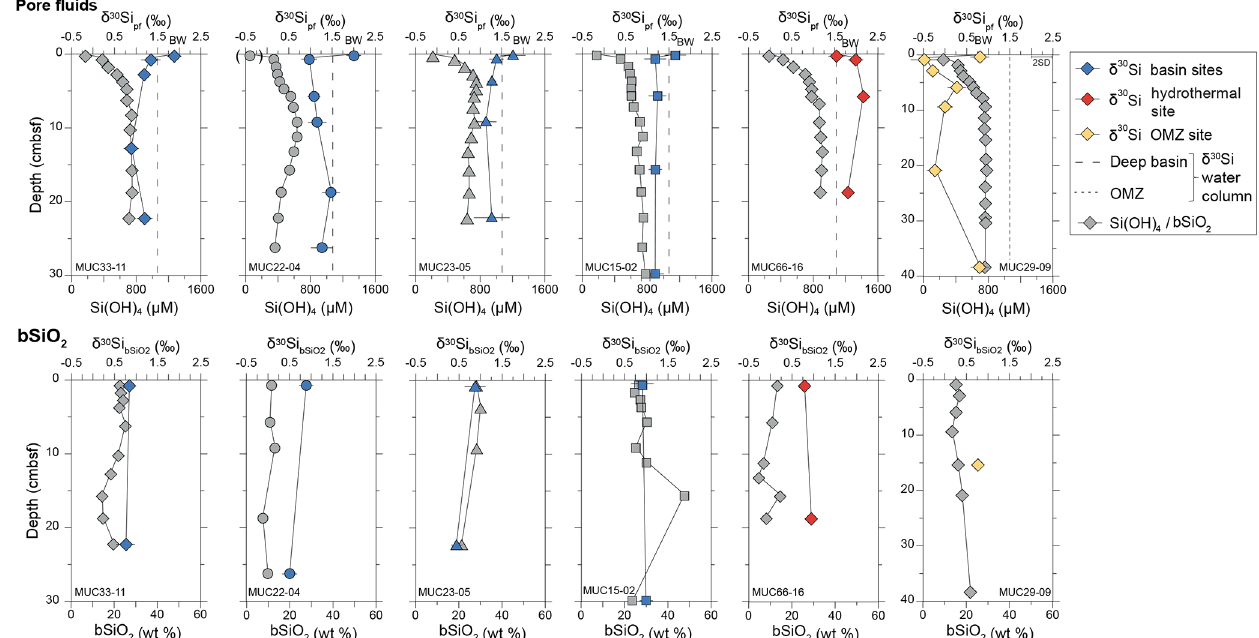
Figure 2. Depth (cmb.s.f.) profiles for all stations for pore fluid Si concentration (Si ( OH ) 4 ) in µM (grey symbols) and δ 30 Si pf values (colored symbols) and biogenic opal weight fraction (bSiO 2 ) in wt% (grey symbols) and δ 30 Si bSiO values (colored symbols). The dashed line is 2 the δ 30 Si value of the deep basin (VCTD02), and the dotted line represents the δ 30 Si value of the water column in the OMZ (VCTD07). The uppermost Si isotope data point in the pore fluid diagrams refers to the bottom water (BW). Note the different depth scale for the OMZ site. The brackets around the MUC22-04 bottom water Si concentration value indicate possible surface water contamination. Error bars not indicated are within symbol size. The long-term error (2SD) of international standards is indicated in the upper right δ 30 Si pf depth